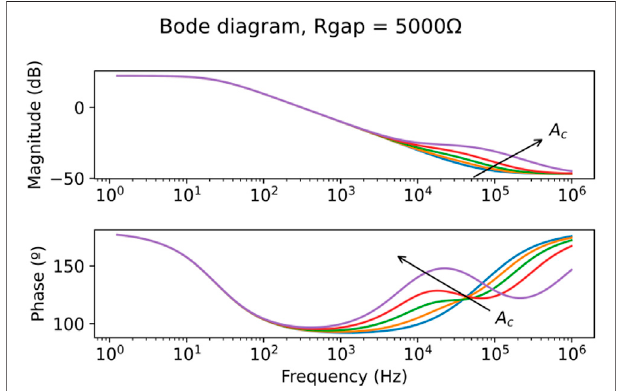
FIGURE 4 | Electrical impedance spectrometry for Hz(s) with R ct (cid:2) 1 . 3 M Ω , C dl (cid:2) 3 . 2 nF , R s (cid:2) 455 Ω , R gap (cid:2) 5000 Ω and variations for A c ∈ ( 0 , A )